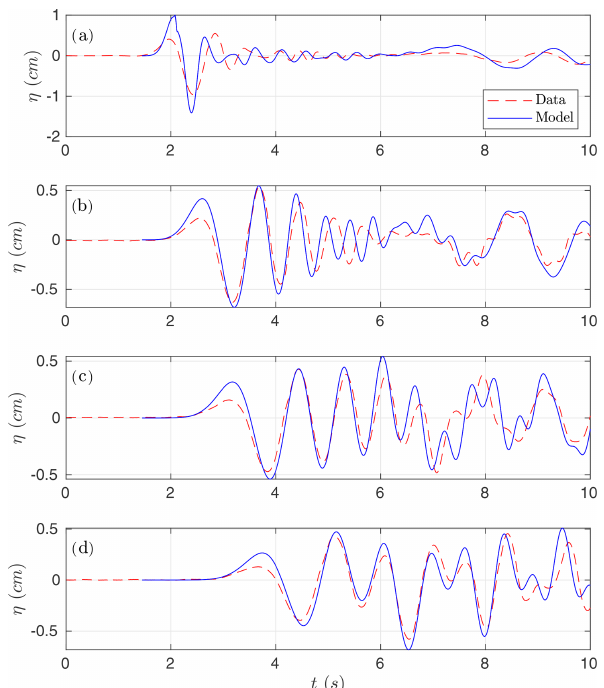
Figure 3. Numerical time series for the simulated water surface (in blue) compared with lab-measured data (red) at wave gauges (a) WG1, (b) WG2, (c) WG3, and (d)